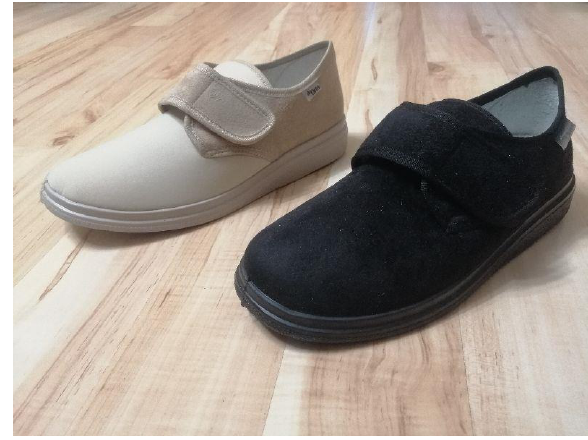
Figure 1. Befado Dr orto footwear used in the study.